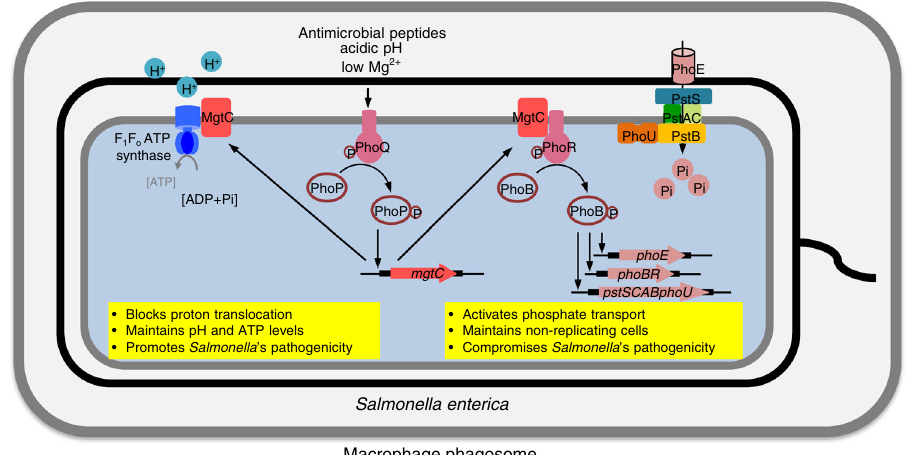
Fig. 6 MgtC reprograms Salmonella ’ s ion uptake inside a macrophage phagosome. On the one hand, MgtC binds to F 1 F o ATP synthase and blocks proton movement across the bacterial inner membrane. This interaction allows Salmonella to maintain cytoplasmic pH and ATP levels and promote pathogenicity. On the other hand, MgtC binds to PhoR histidine kinase and activates phosphate transport in the bacterial membrane by promoting transcription of the PhoB-dependent genes involved in phosphate transport. Phosphate uptake mediated by MgtC is involved in the maintenance of non-replicating